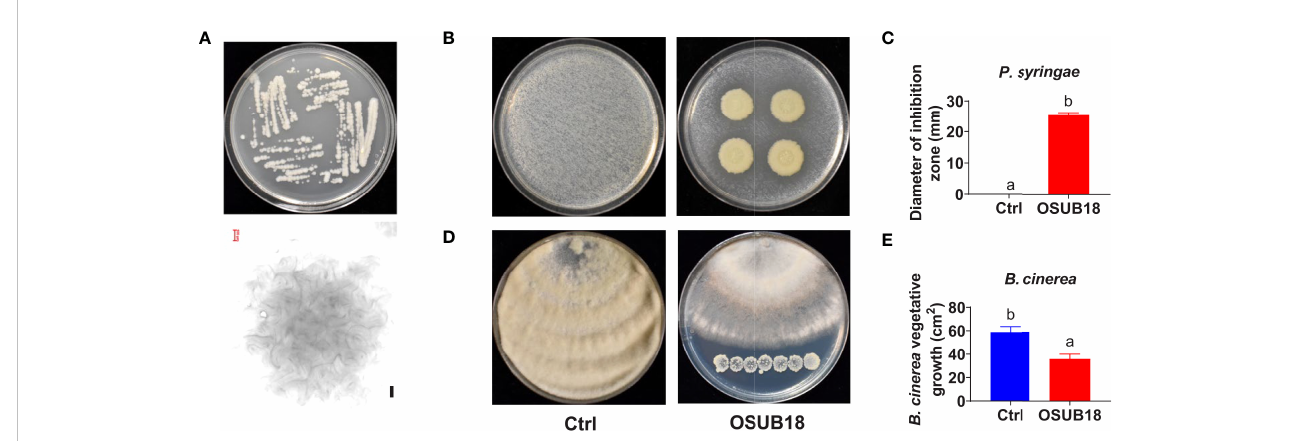
FIGURE 1 Isolation and identi fi cation of OSUB18 for bacterial speck disease and fungal gray mold disease control. (A) Colony morphology of OSUB18 on Tryptic Soy Agar (TSA) after 24 hours of incubation at 28°C. The bottom panel is the microscopic image of one representative colony from the upper panel. Scale bar = 100 µm. (B) OSUB18 antagonized the bacterial speck disease-causing agent P. syringae . (C) Quanti fi cation of the inhibition zone in (B) . (D) OSUB18 antagonized the gray mold disease-causing agent B cinerea . Note that there was no physical contact between the bacterium and the fungus. (E) Quanti fi cation of the fungal growth in (D) . Data present mean ± SE of three biological replicates. Data with different letters indicate a p- value < 0.05 on Student ’ s